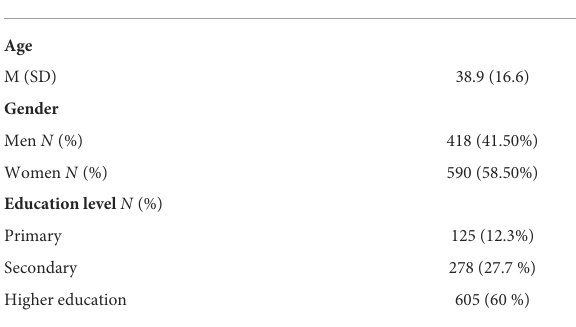
TABLE 1 Sociodemographic characteristics in T0 ( N =